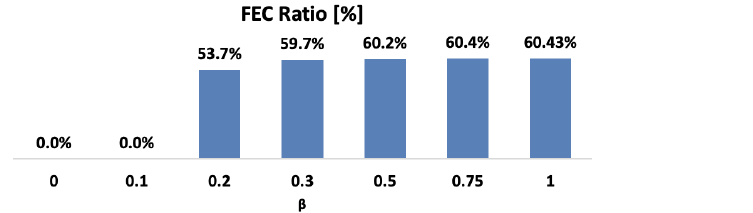
Figure 9. Optimal energy selling via forward contracts for different risk aversion levels- stochastic case.